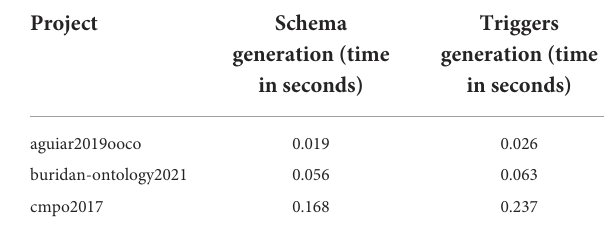
TABLE 5 Transformation design time